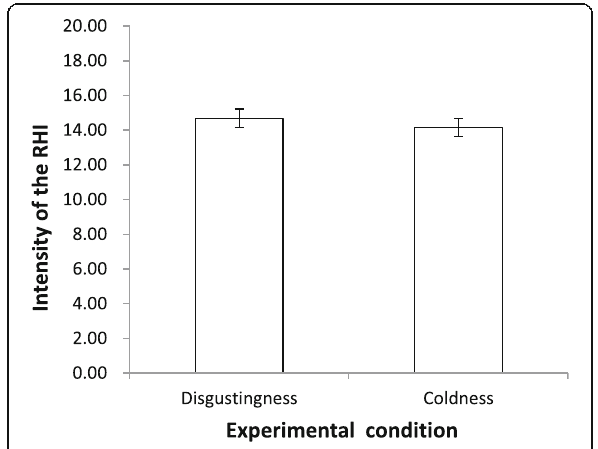
Fig. 5 Participants ’ mean scores on the intensity of the RHI scale. The scores during the synchronous condition in the disgustingness and coldness conditions are plotted. Error bars represent the standard error of the